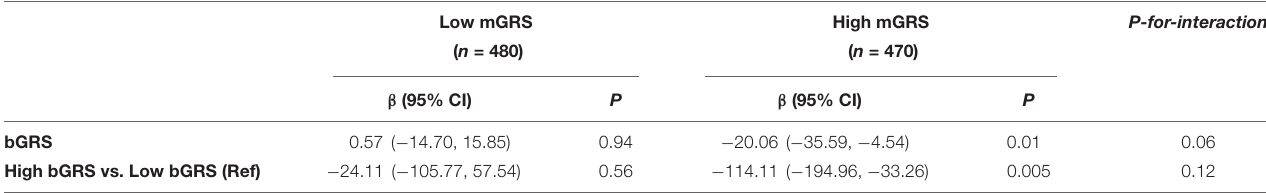
TABLE 4 | Association of fetal obesity genetic risk with birthweight stratified by maternal obesity genetic risk status a